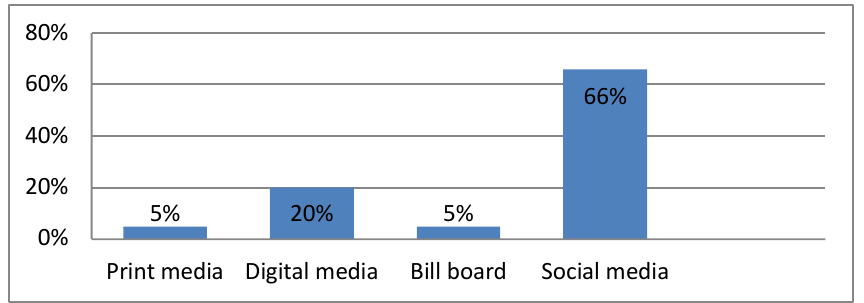
Figure 7 : medium of advertisement which you usually see.